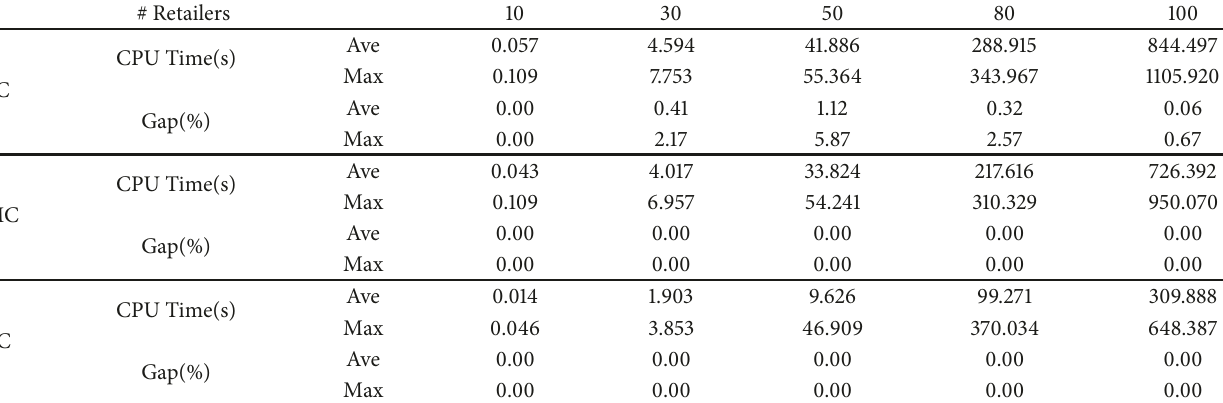
Table 3: Performance of the algorithm for solving P 𝑗